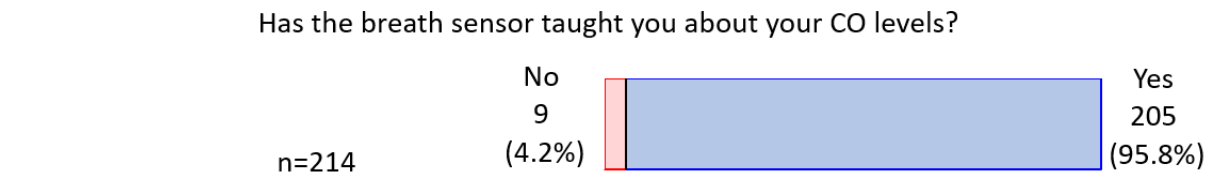
At 3 weeks, the majority (>90%, >196/214) of participants indicated the breath sensor had taught them about their CO levels and smoking behavior (Figures 11 and 12). Figure 11. Participant Feedback: Has the breath sensor taught you about your carbon monoxide (CO) levels? (week 3).